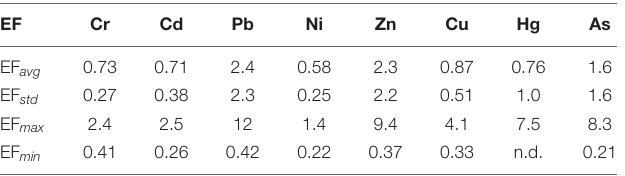
TABLE 5 | The enrichment factor for studied metals in soil